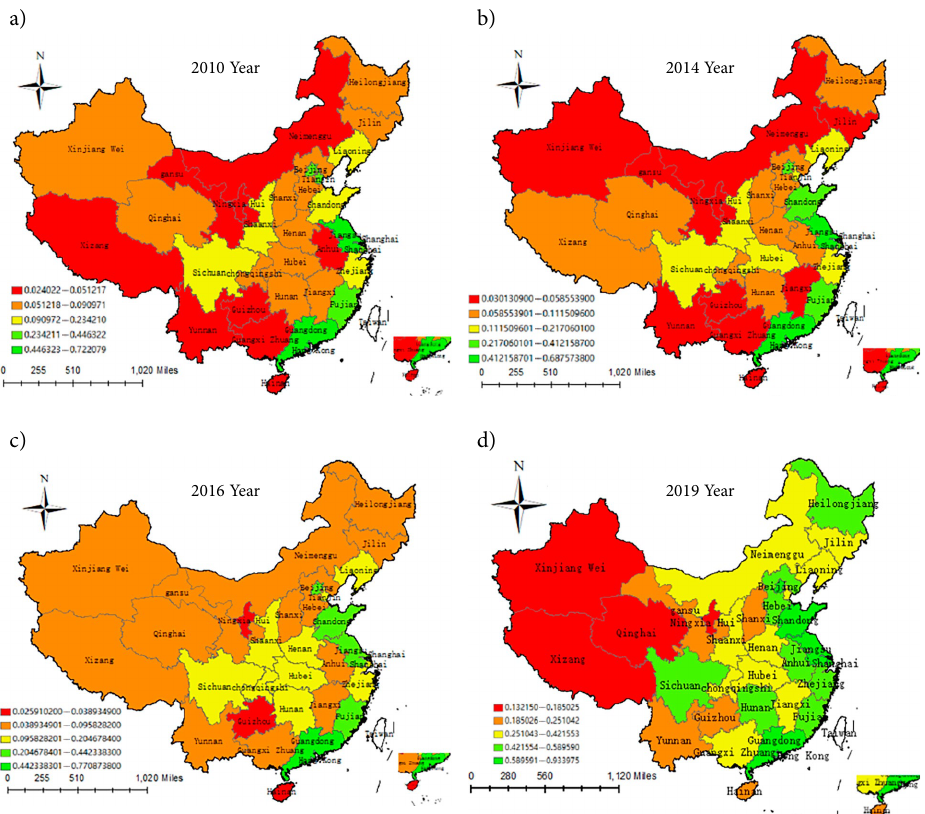
Figure 7. Spatial map of China’s DDE: a) – 2010 year; b) – 2014 year; c) – 2016 year; d) – 2019